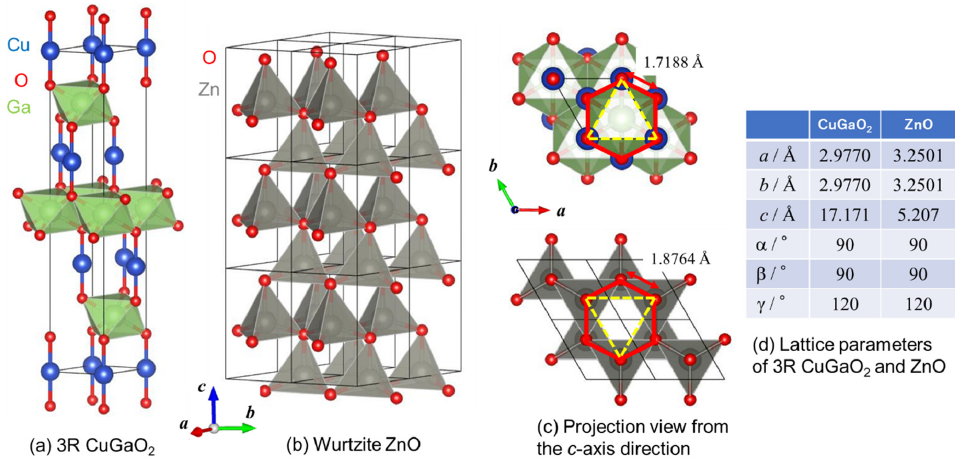
Figure 1. Crystal structures of ( a ) rhombohedral (3R) CuGaO 2 and ( b ) wurtzite ZnO. ( c ) Projection views of 3R CuGaO 2 ( top ) and wurtzite ZnO ( bottom ). ( d ) Comparison of lattice parameters ( a , b , c , α , β , and γ ) between 3R CuGaO 2 (PDF 01 ‐ 082 ‐ 8561) and ZnO (PDF 04 ‐ 003 ‐ 2106). Cu and Zn exhibit similar stacking in the c plane, indicating the possibility to form a heterostructure between them via Cu–O–Zn bonding in the c ‐ axis direction.